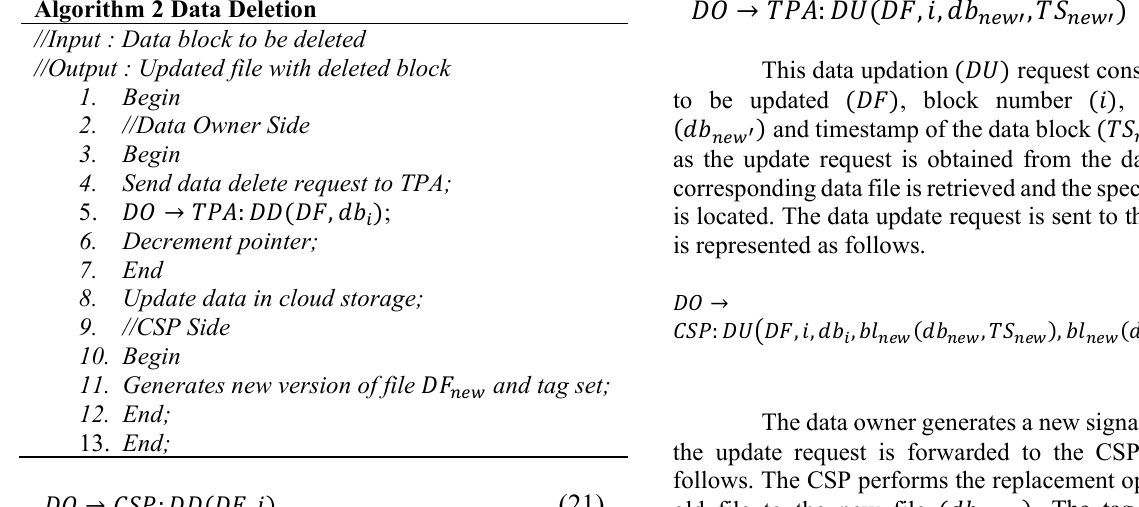
Algorithm 2 Data Deletion